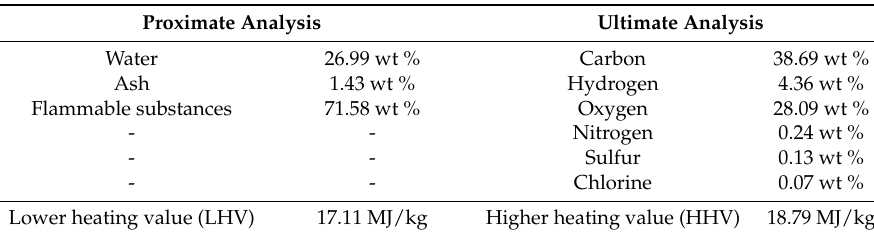
Table 1. Properties of the pyrolysis bio ‐ oil.